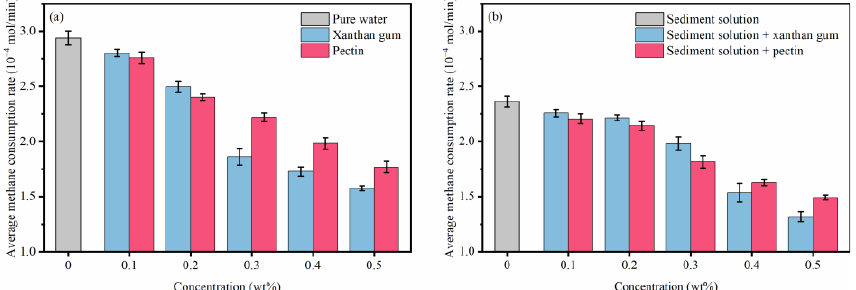
Figure 6. Effects of xanthan gum and pectin on the hydrate formation rate: ( a ) pure water systems; ( b ) sediment solution systems.